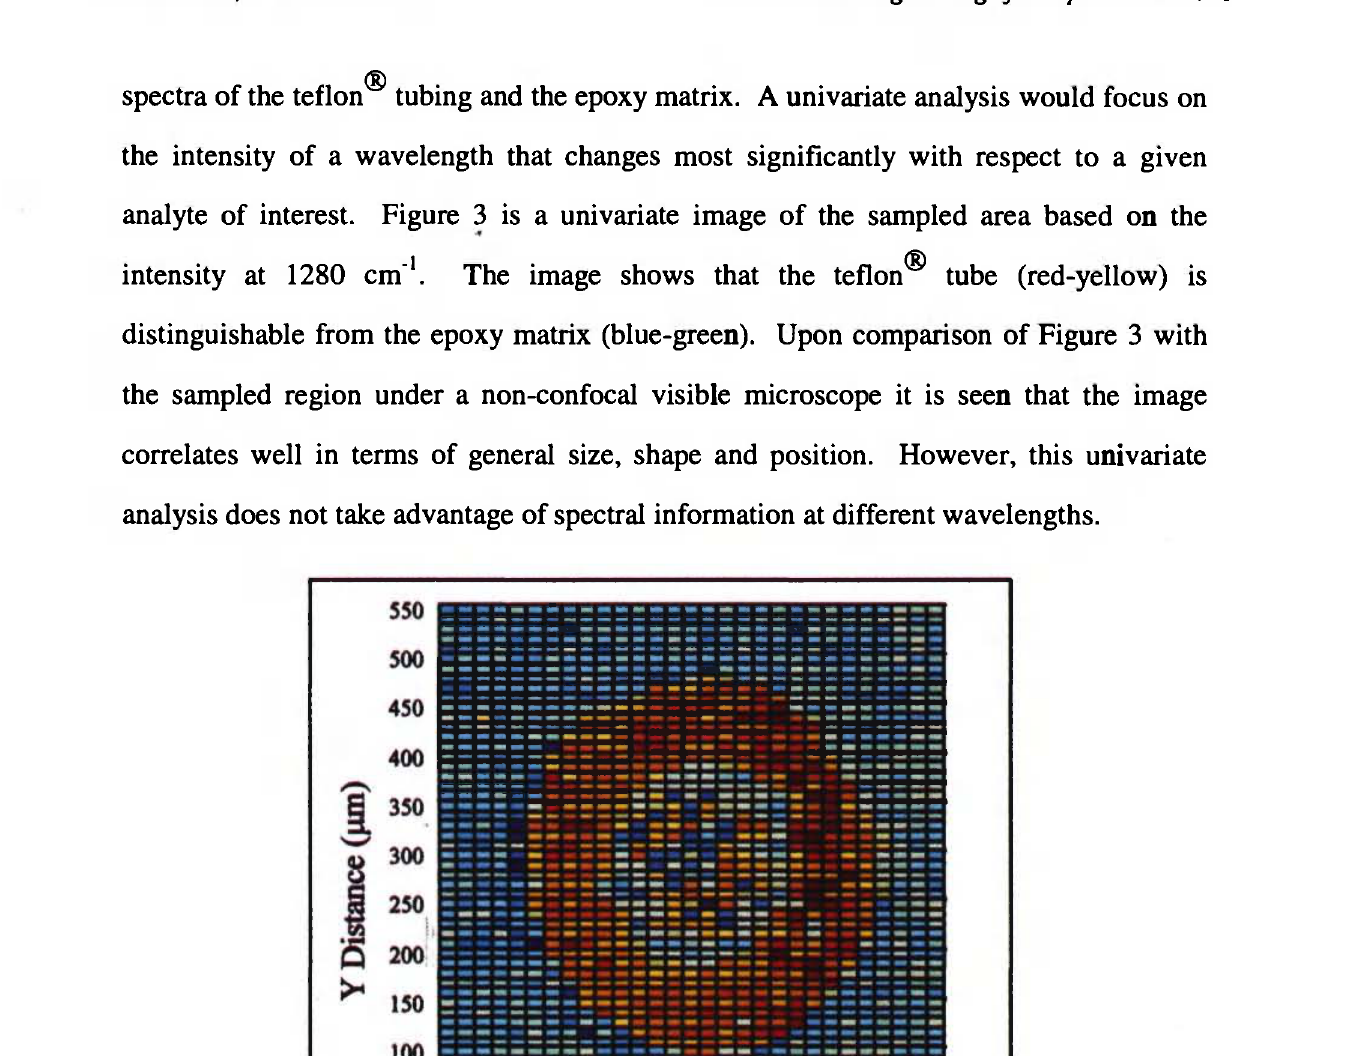
® Figure 3: Univariate image of a teflon tube (red-yellow) embedded in an epoxy matrix (blue-green). Based on the Raman intensity at 1280 cm' 1